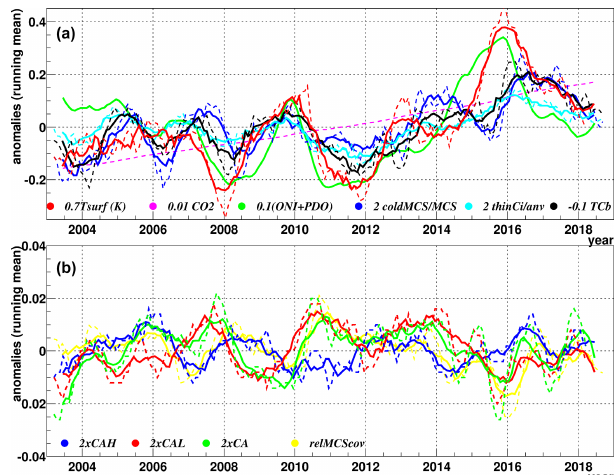
Figure 11. (a) Time series of 12-month running means (bold lines) and 6-month running means of deseasonalized anomalies of tropical surface temperature (ERA-Interim), ENSO index (ONI) and Inter- decadal Pacific Oscillation (PDO) index, as well as coverage of cold MCSs over all MCSs (multiplied by 2), area of thin cirrus over area of total cirrus anvil (multiplied by 2), convective core temper- ature (in K, multiplied by − 0 . 1) and increase of CO 2 concentration (in ppm, multiplied by 0.01). (b) Time series of 12-month running means of deseasonalized anomalies of cloud cover (CA), UT cloud cover (CAH) and low-level cloud cover (CAL), multiplied by 2, and of relative MCS